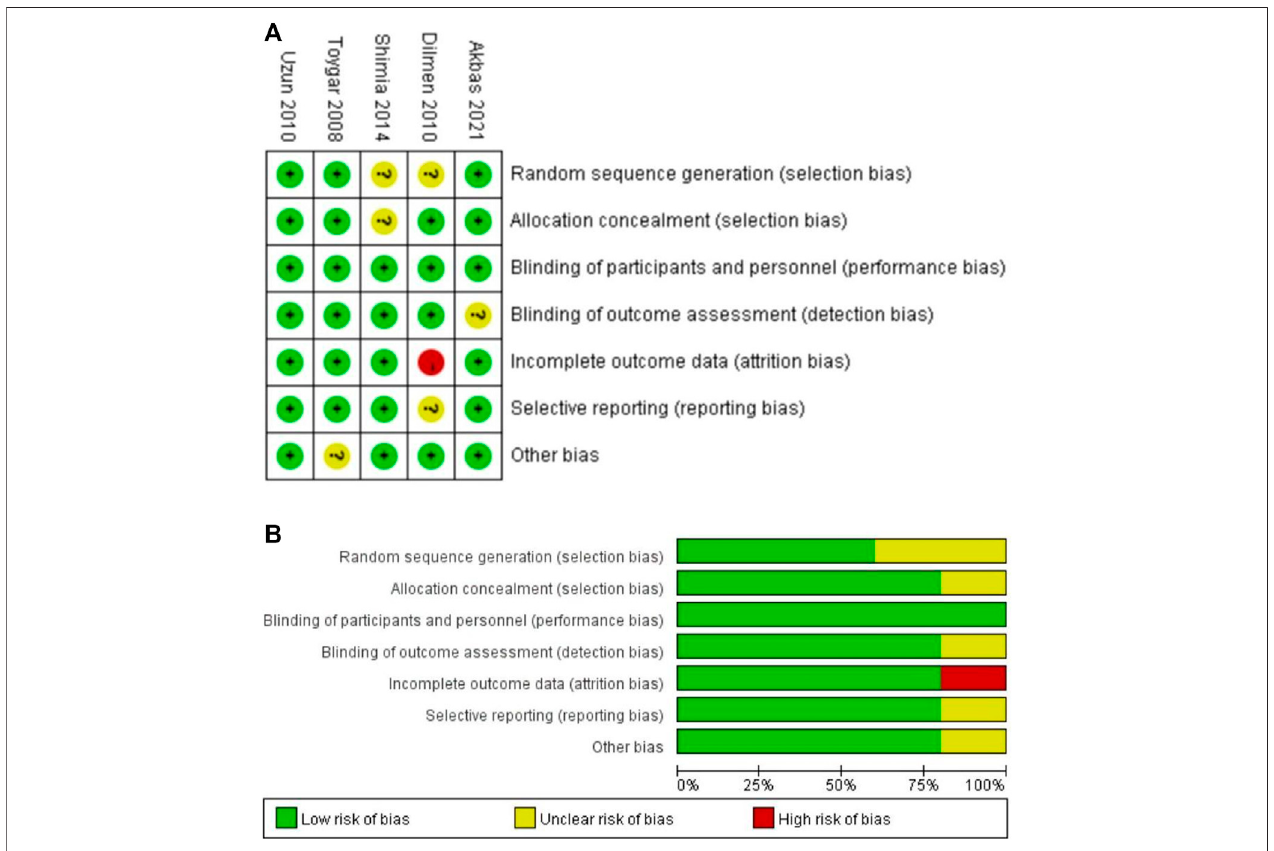
FIGURE 2 | Risk of bias assessment. (A) Risk of the bias summary. (B) Risk of the bias graph. The green and plus signs indicate low risk, the red and minus signs indicate high risk, and the yellow and question marks indicate uncertain risk.